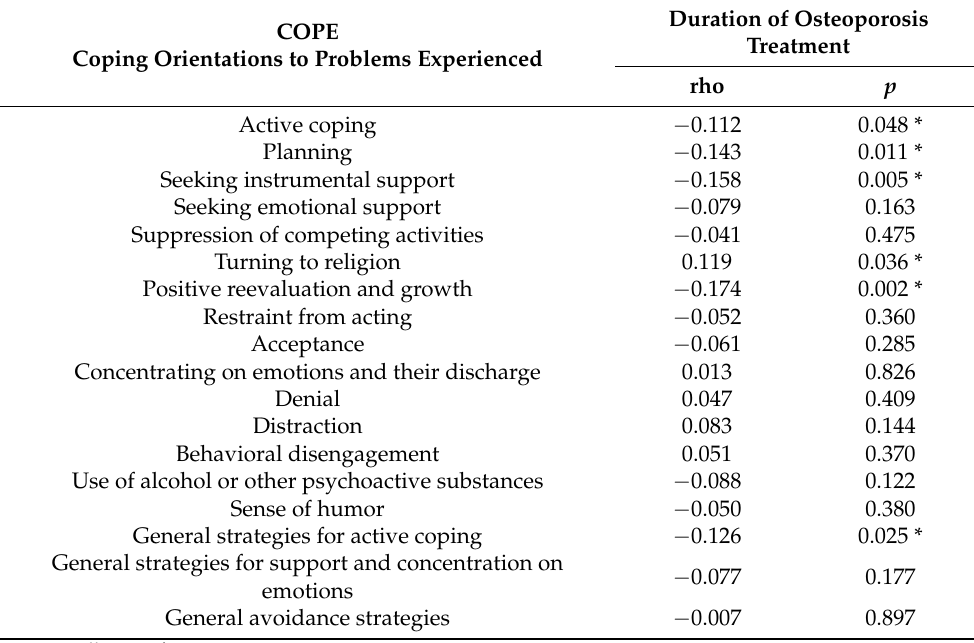
Table 3. Correlations between treatment duration and strategies of coping with